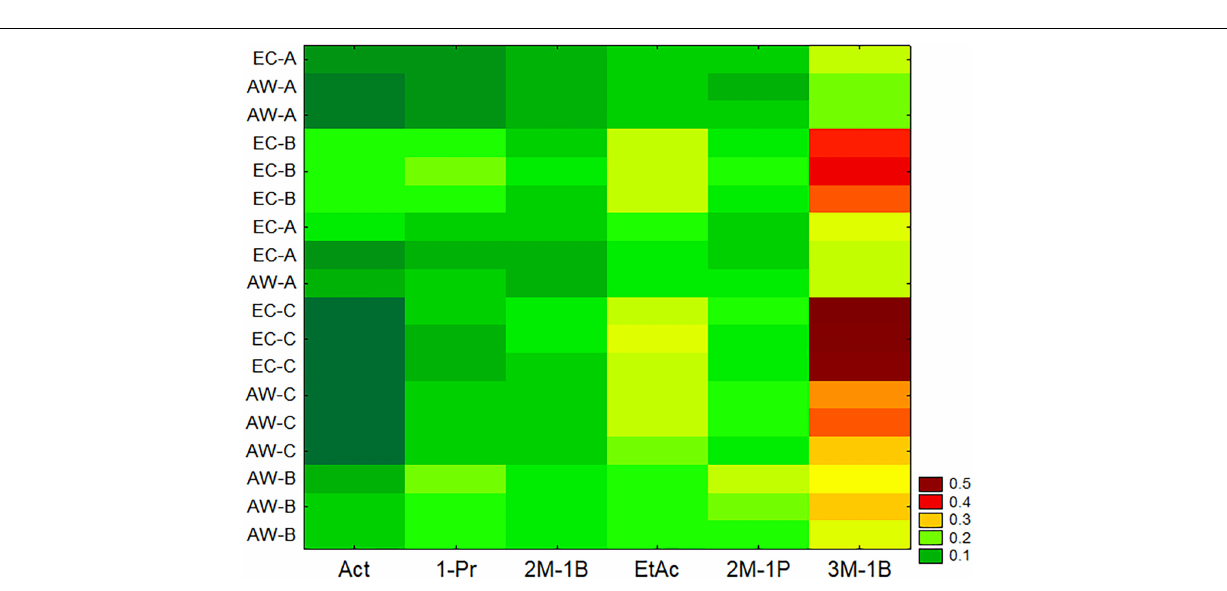
FIGURE 2 | Two-way joining of the main by-products formed by the two Saccharomyces cerevisiae strains in synthetic must trials carried out by three RUs (A, B, and C). Act, acetaldehyde; 1-Pr, 1-propanol; 2M-1B, 2-methyl-1-butanol; EtAc, ethyl acetate; 2M-1P, 2-methyl-1-propanol; 3M-1B, 3-methyl-1-butanol; ppm per gram of consumed